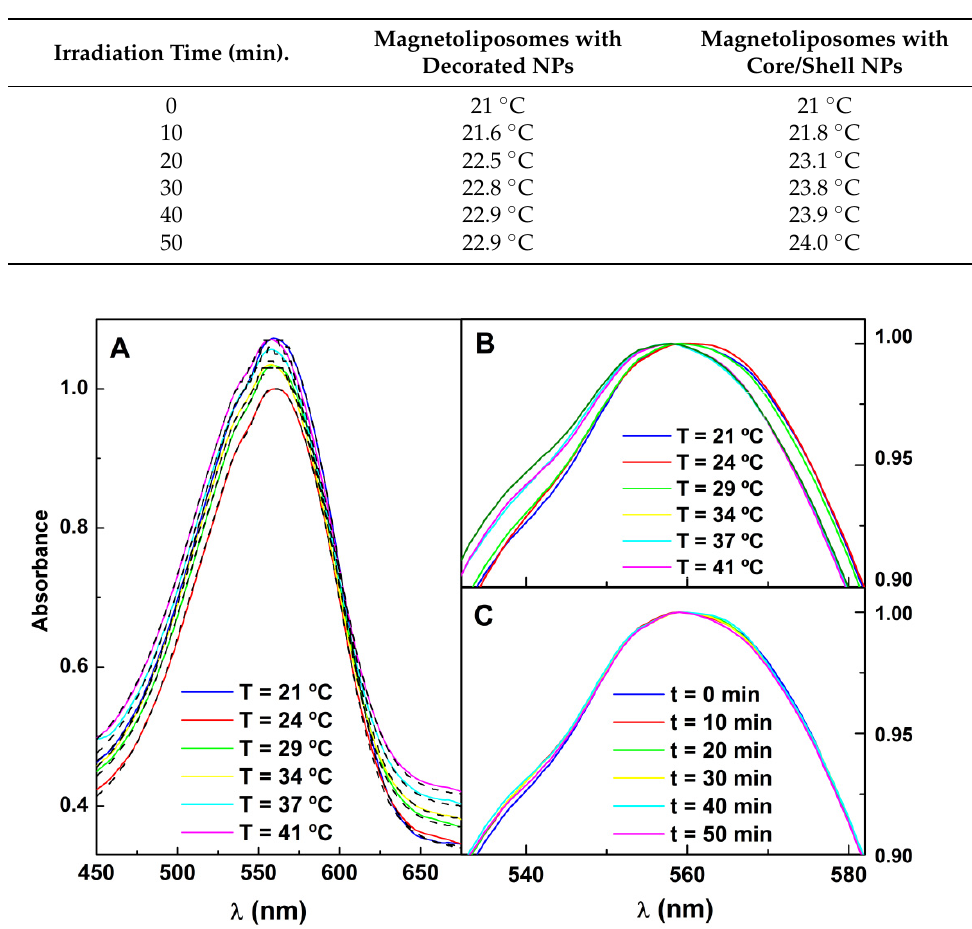
Figure 10. ( A ) Variation of absorption spectra of Nile Red in magnetoliposomes containing core/shell nanoparticles, at different temperatures and fitting to the model (dashed curves). ( B ) Expansion of the normalized spectra of Figure A in the maxima region. ( C ) Expansion of the normalized spectra in the maxima region at several times of irradiation.